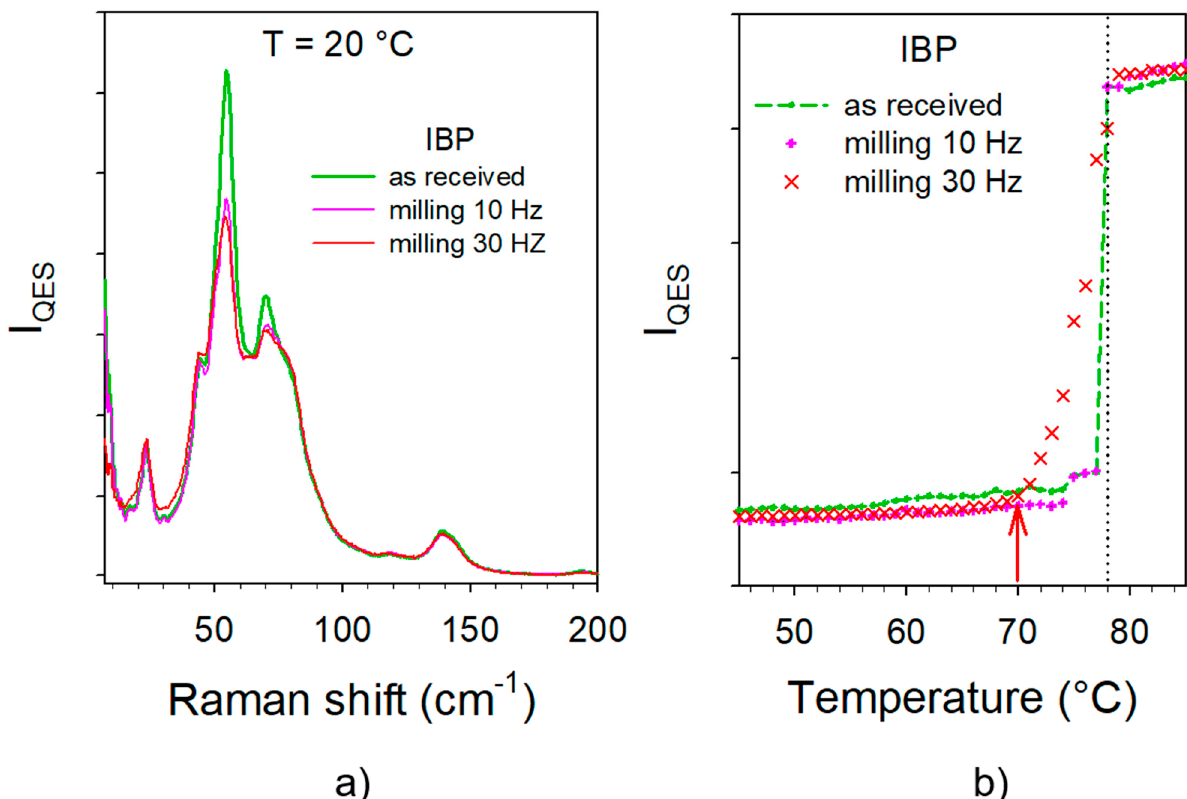
Figure A1. Influence of milling on the physical state of IBP: ( a ) comparison between spectra of as-received IBP and milled IBP at 10 Hz and 30 Hz; ( b ) I QES (T) curves of as-received sample and milled samples.